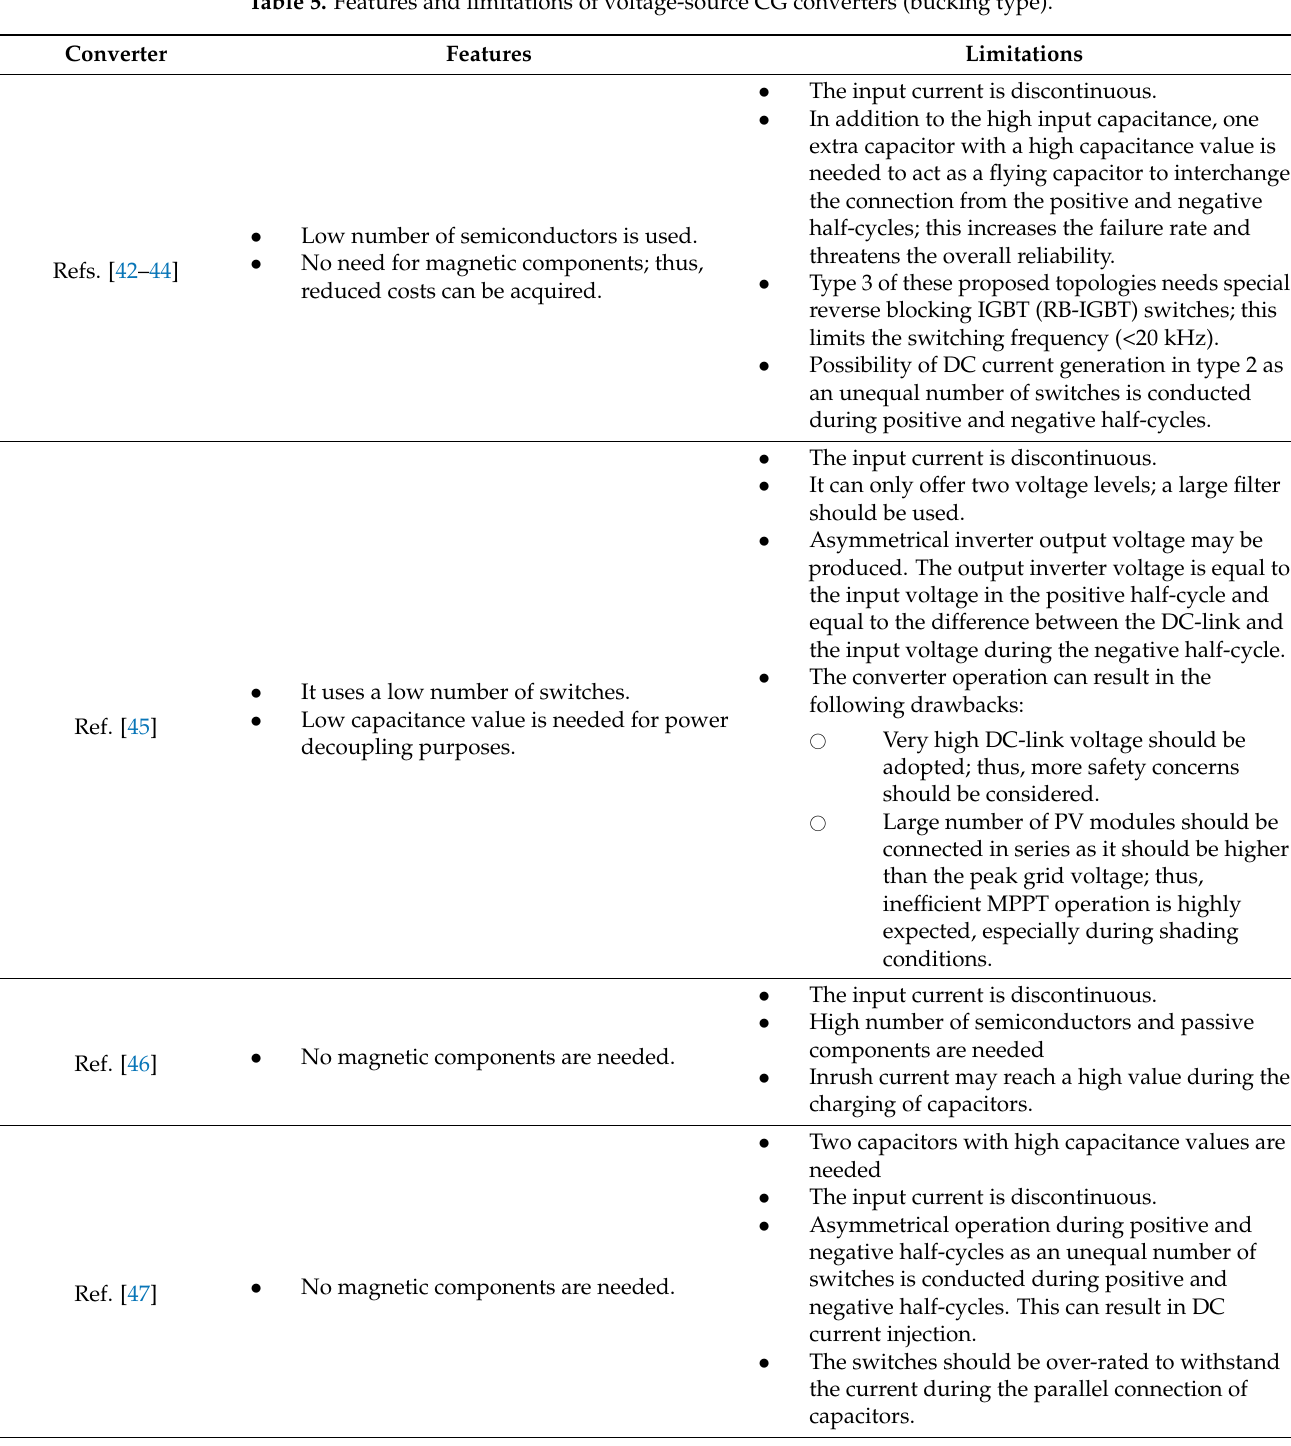
Table 5. Features and limitations of voltage-source CG converters (bucking